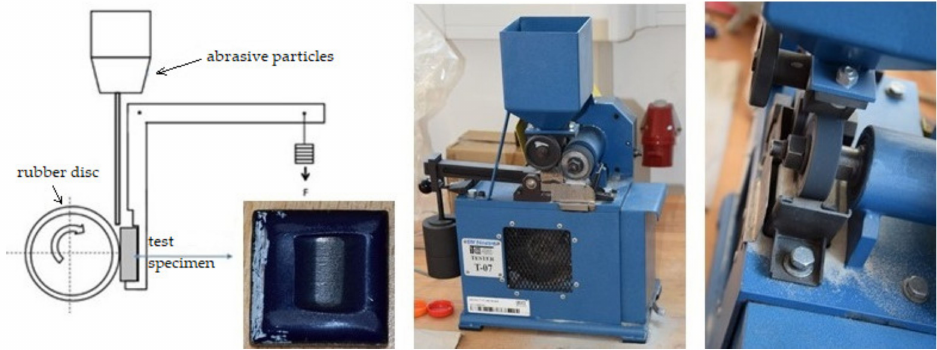
Figure 3. Representation of the device with a rubber disc and the test